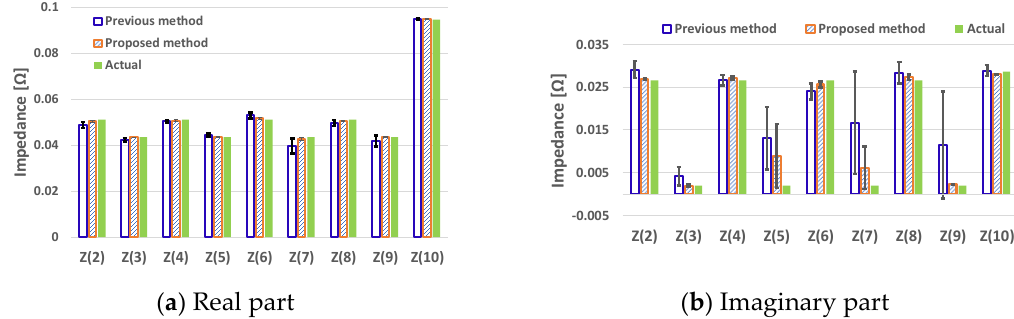
Figure 3. Average and 95% confidence interval for estimated impedance (real and imaginary part).